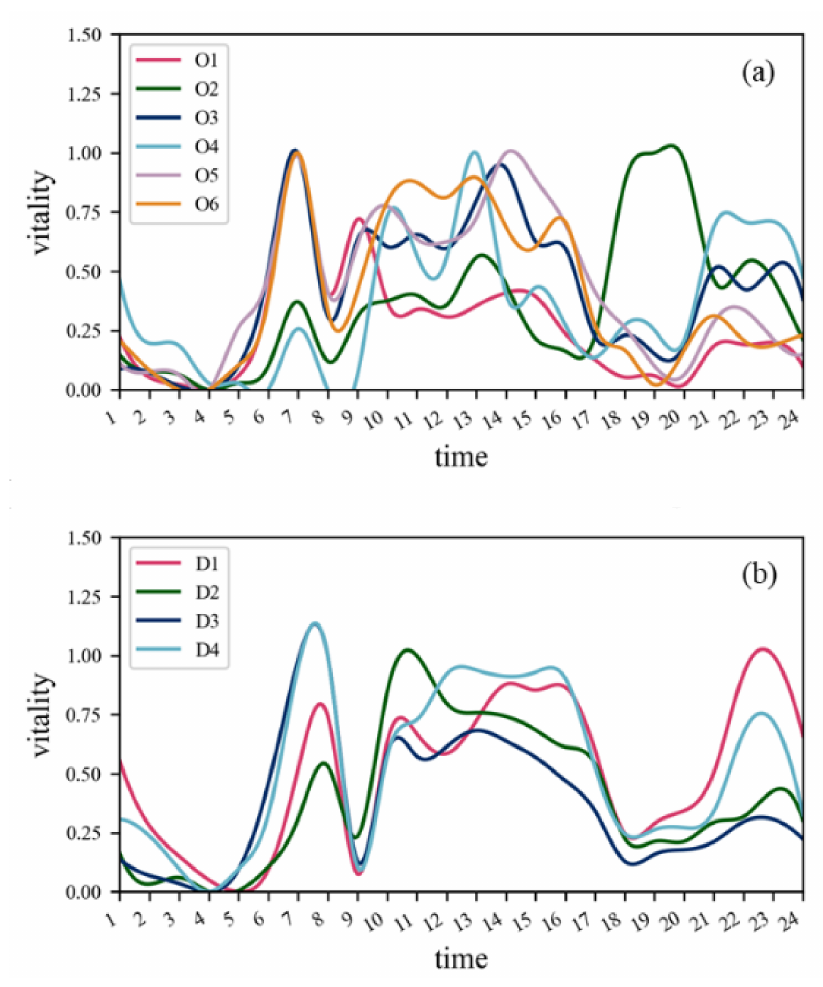
Figure 6. Time distribution of different activities in origin ( a ) and destination ( b